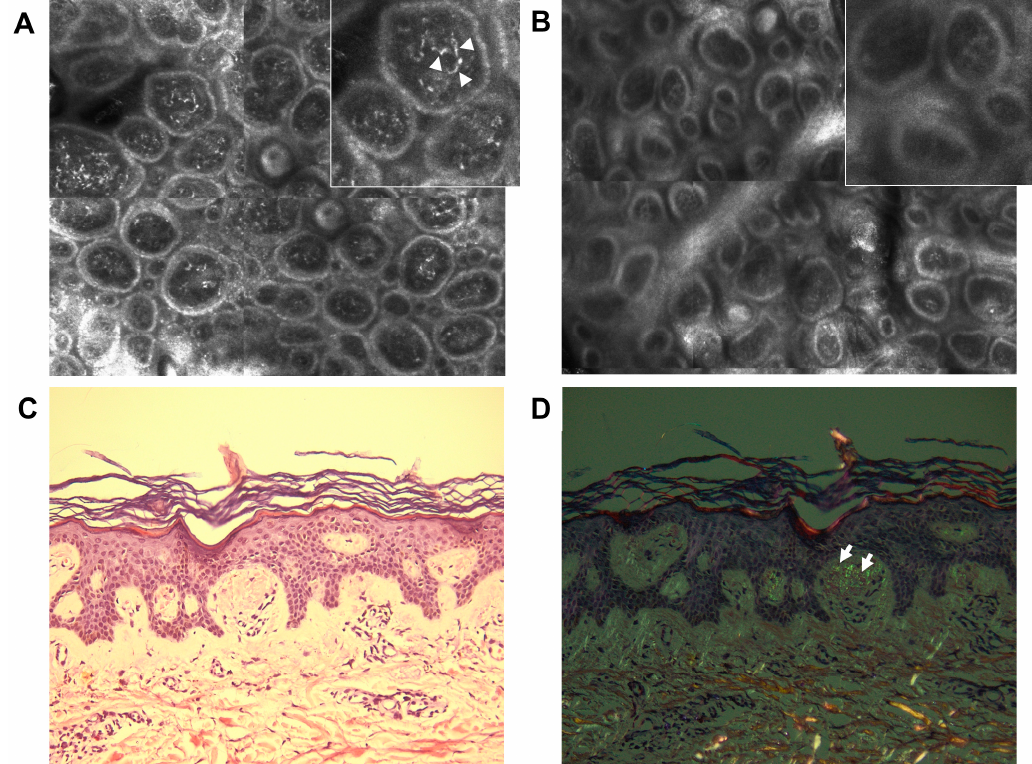
Figure 2. Correlation between reflectance confocal microscopy (RCM) and histological images: ( A ) RCM mosaic (1.5 × 1 mm) and detail (0.25 × 0.25 mm) from the dermoepidermal junction level of the a ff ected skin showing highly refractile structures with various shapes (dotted, coliform, and agglomerates) inside dermal papillae (white short arrows). ( B ) RCM mosaic (1.5 × 1 mm) and detail (0.25 × 0.25 mm) from the dermoepidermal junction level of clinically una ff ected skin. Histopathological images showing ( C ) purple amyloid deposits in the papillary dermis ( × 20, Congo red stain) and ( D ) the green-yellow birefringence (white short arrows) of amyloid deposits inside dermal papillae ( × 20, Congo red stain, polarized microscopy).